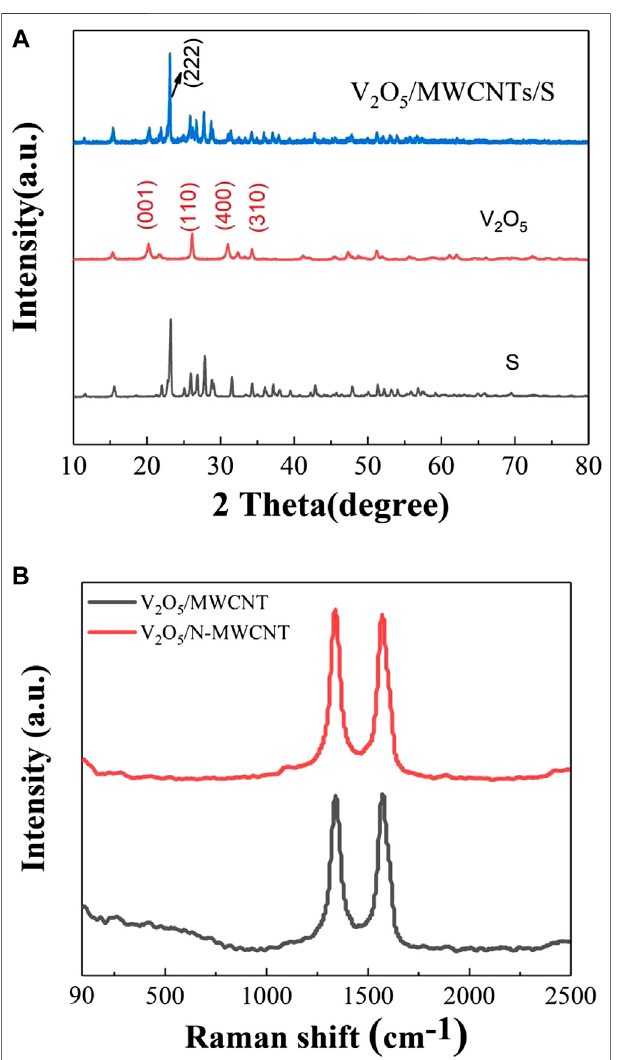
FIGURE 4 | (A) TG curves for the MWCNT/S, V 2 O 5 /MWCNT/S, and V 2 O 5 /N-MWCNT/S composite materials. (B) N 2 adsorption-desorption isotherm of V 2 O 5